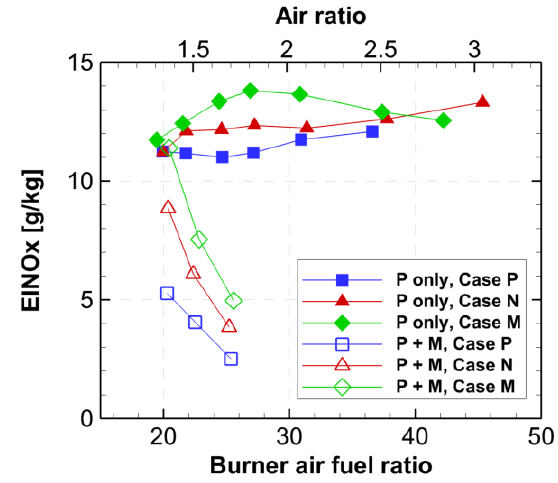
Figure 20. NO x emission index under cruising conditions. (Copyright by ASME — "Effects of Fluidic Control of Air-Flow Distribution on Staged Lean Jet Engine Burner," by Yoshida, Schneider, Hassa, Paper No: GT2016-57453).